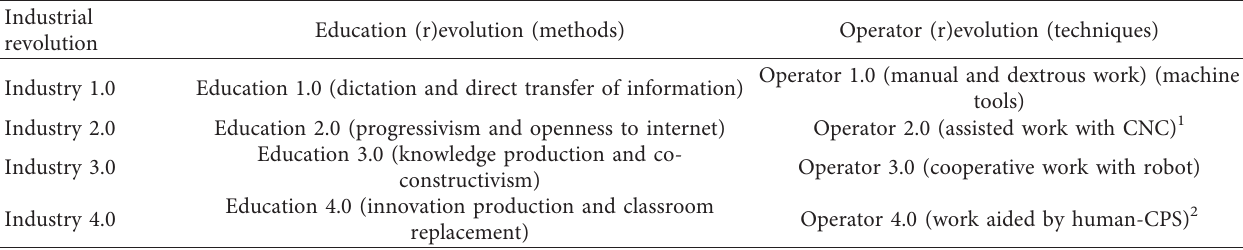
Table 4: Paradigm shift in industry, education, and